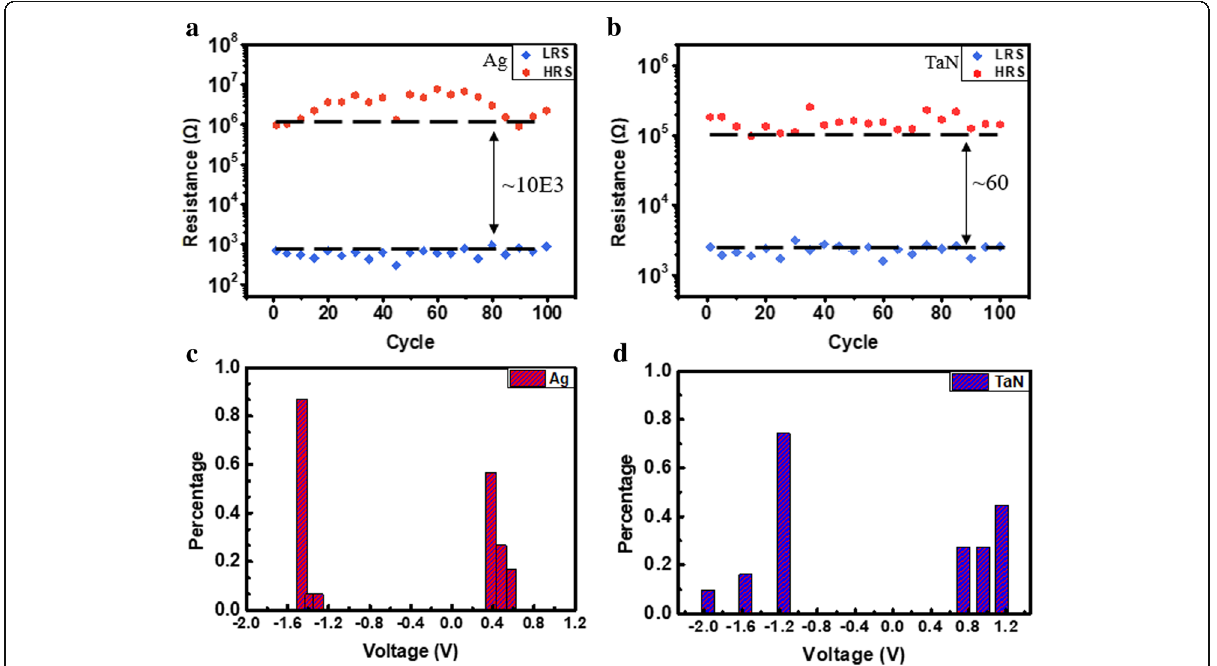
Fig. 3 Endurance characteristics and set/reset distribution of Ag/HfAlOx/Pt ( a , c ) and TaN/HfAlOx/Pt device ( b , d ) under 100 consecutive DC sweeping